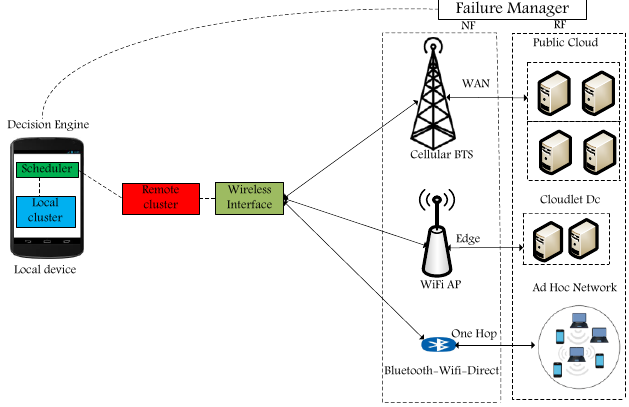
Figure 2. Fault Tolerant Offloading